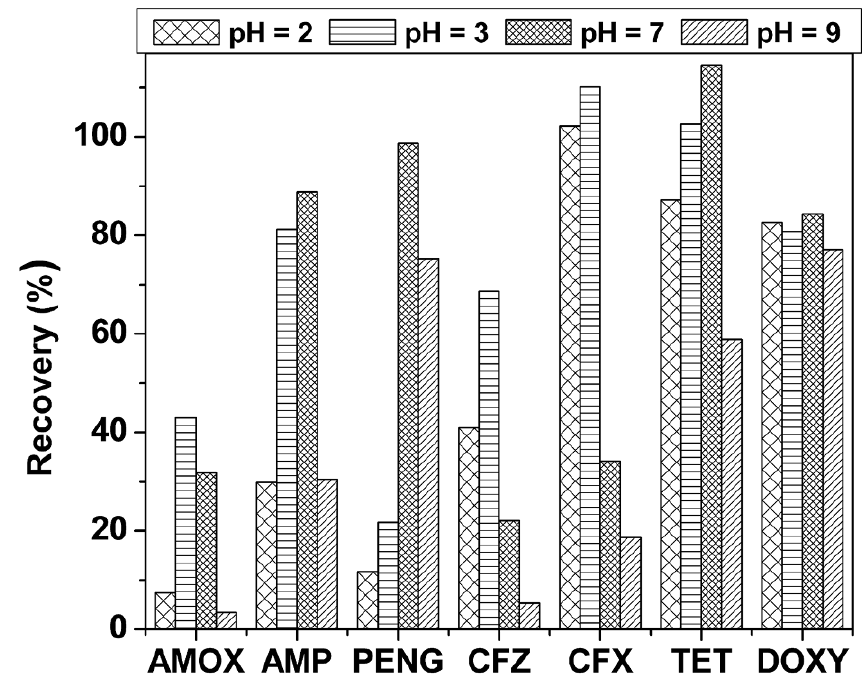
Figure 1. Effects of pH values on SPE recoveries of the selected